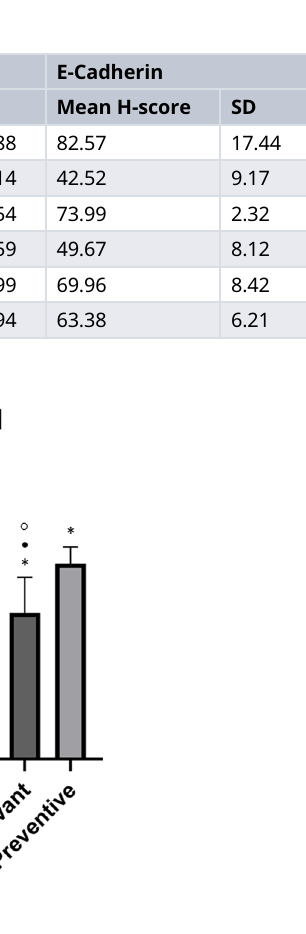
Figure 2. Effect of ICAM-1 in all groups. Normal, positive control (PC), curative, adjuvant, and preventive groups have significantly different ICAM-1 expressions compared to the negative control (NC). Duncan Test was used to determine the difference between groups. * represents significant difference (p < 0.05) of groups versus NC. ○ represents a significant difference (p < 0.05) of groups versus preventive.